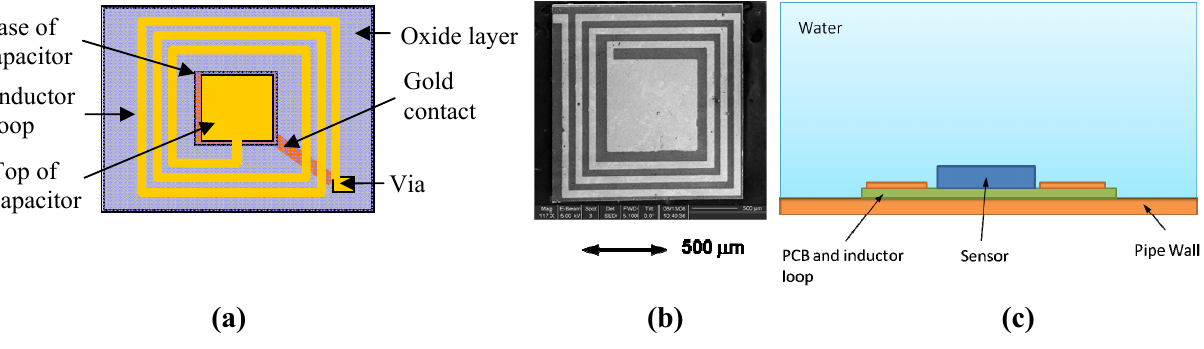
Figure 17. (a) Schematic of and (b) Scanning Electron Microscope image of the MEMS oscillating circuit [29] and (c) potential application on a